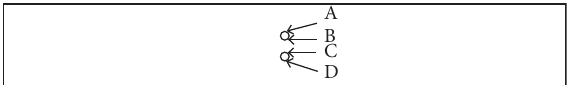
Figure 4: Schematic diagram of two-hole plate